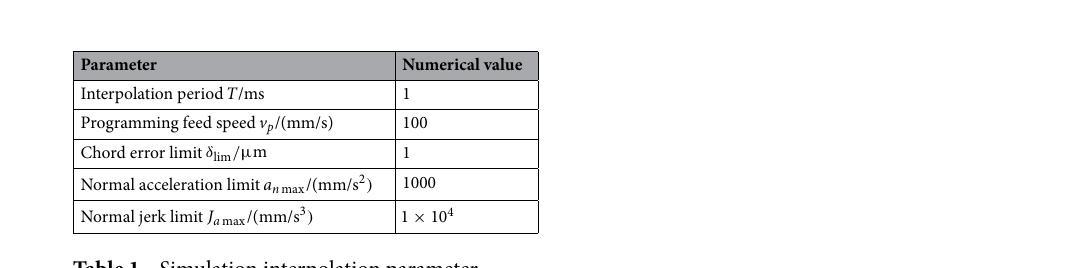
Table 1. Simulation interpolation